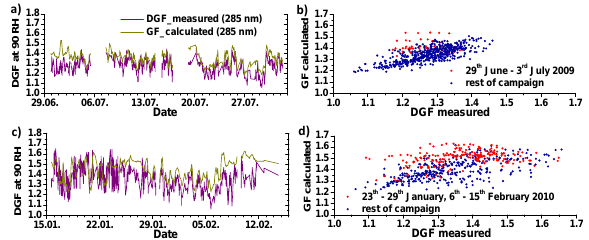
Fig. 9. Time series (a, c) and scatter plots (b, d) of the measured Figure 9. Time series (a, c) and scatter plots (b, d) of the measured DGF and the calculated 3 DGF and the calculated GF for 285nm particles, respectively, com- GF for 285 nm particles, respectively, computed with the bulk chemical composition 4 puted with the bulk chemical composition measured by the AMS. measured by the AMS. The correlation coefficient of the two time series are R=0.66 (a) and 5 The correlation coefficient of the two time series are R = 0 . 66 (a) R=0.52 (b). Red dots in the scatter plots denote periods under high NOx conditions. 6 and R = 0 . 52 (b) . Red dots in the scatter plots denote periods under high NO x